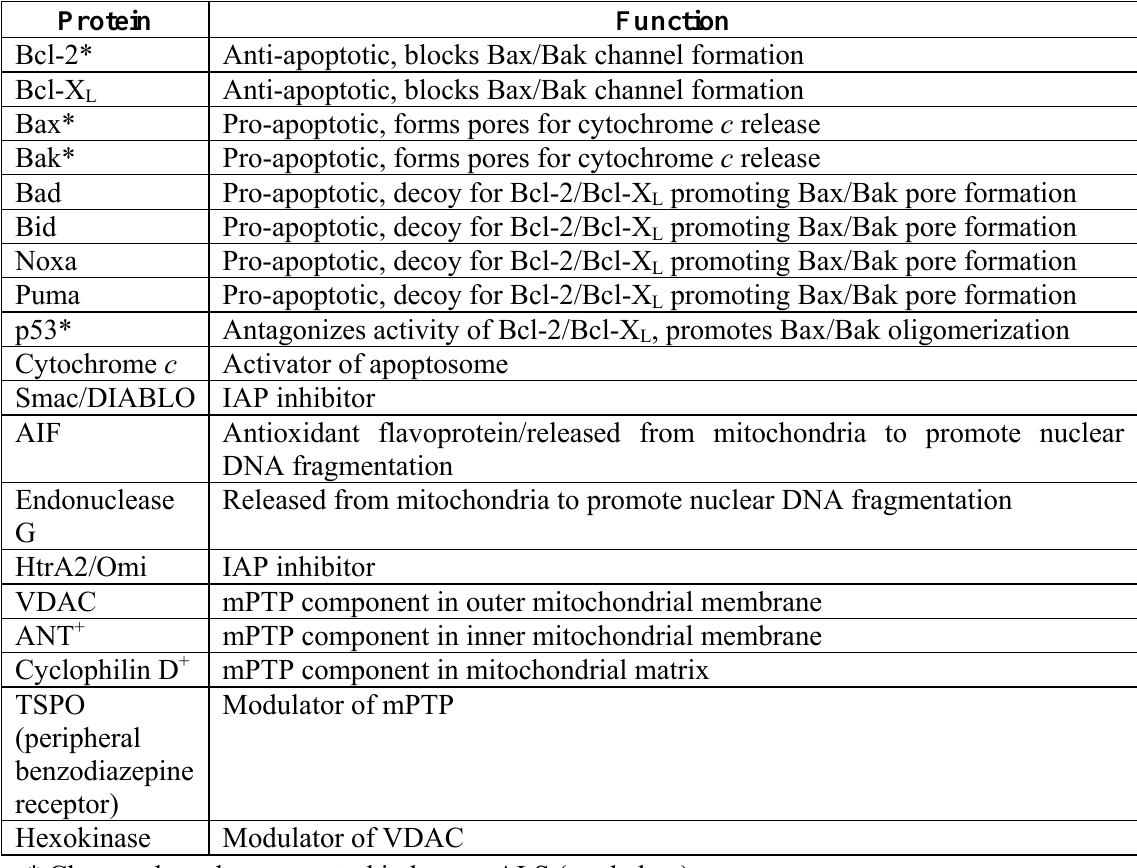
Table 1. Some Mitochondrial Associated Cell Death